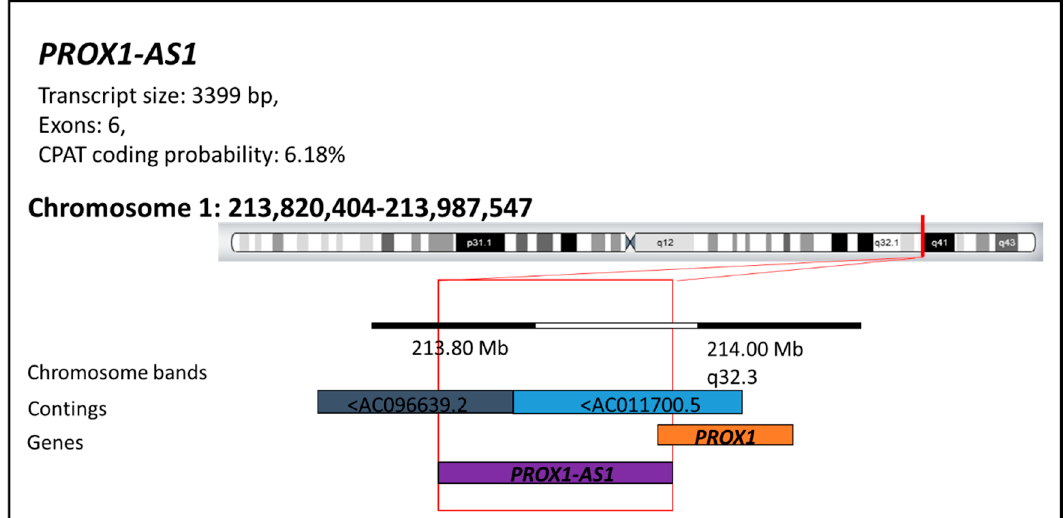
Figure 1. The PROX1 antisense RNA 1 structure ( PROX1-AS1 ). The PROX1-AS1 presents a transcript of 3399 bp, including six exons with a faint (6.18%) probability of protein translation (according to the Coding-Potential Assessment Tool (CPAT)). LncRNA- PROX1-AS1 is located on the long arm of chromosome 1 at position 1q32.3 (start position: 213820404; end position: 213987547) in the regions AC096639.2-AC011700.5 of the DNA segments. This information is available at LNCipedia [29], RNA central [30], and Ensemble [31] databases.